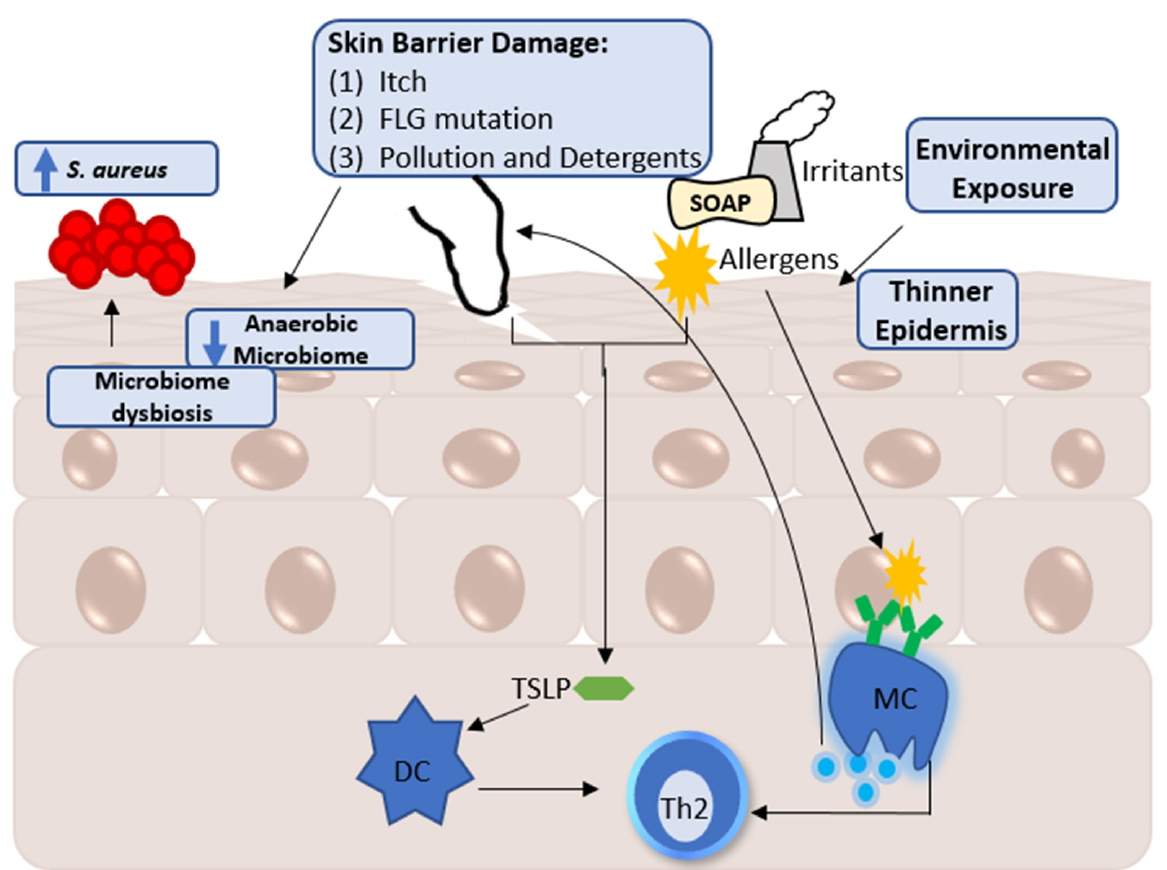
Figure 1. Model of AE development. The environment and the host could both drive the development of atopic eczema (AE). AE is characterized as having a disrupted skin barrier which could be induced through itching, filaggrin (FLG) mutation, and environmental exposures. The disruption then allows for oxygen to penetrate the skin, resulting in a decrease in the anaerobic microbiome and providing a new niche for bacterial growth. Microbial dysbiosis within AE could be a result of this niche, or could be the result of changing pH, salt levels, and/or other factors within the skin. This dysbiosis then provides the opportunity for S. aureus to overgrow. In addition, both scratching and allergens result in keratinocytes releasing cytokines, such as the thymic stromal lymphopoietin (TSLP). The recruitment. AE non-lesional skin also has a thinner epidermis, allowing for easier penetration